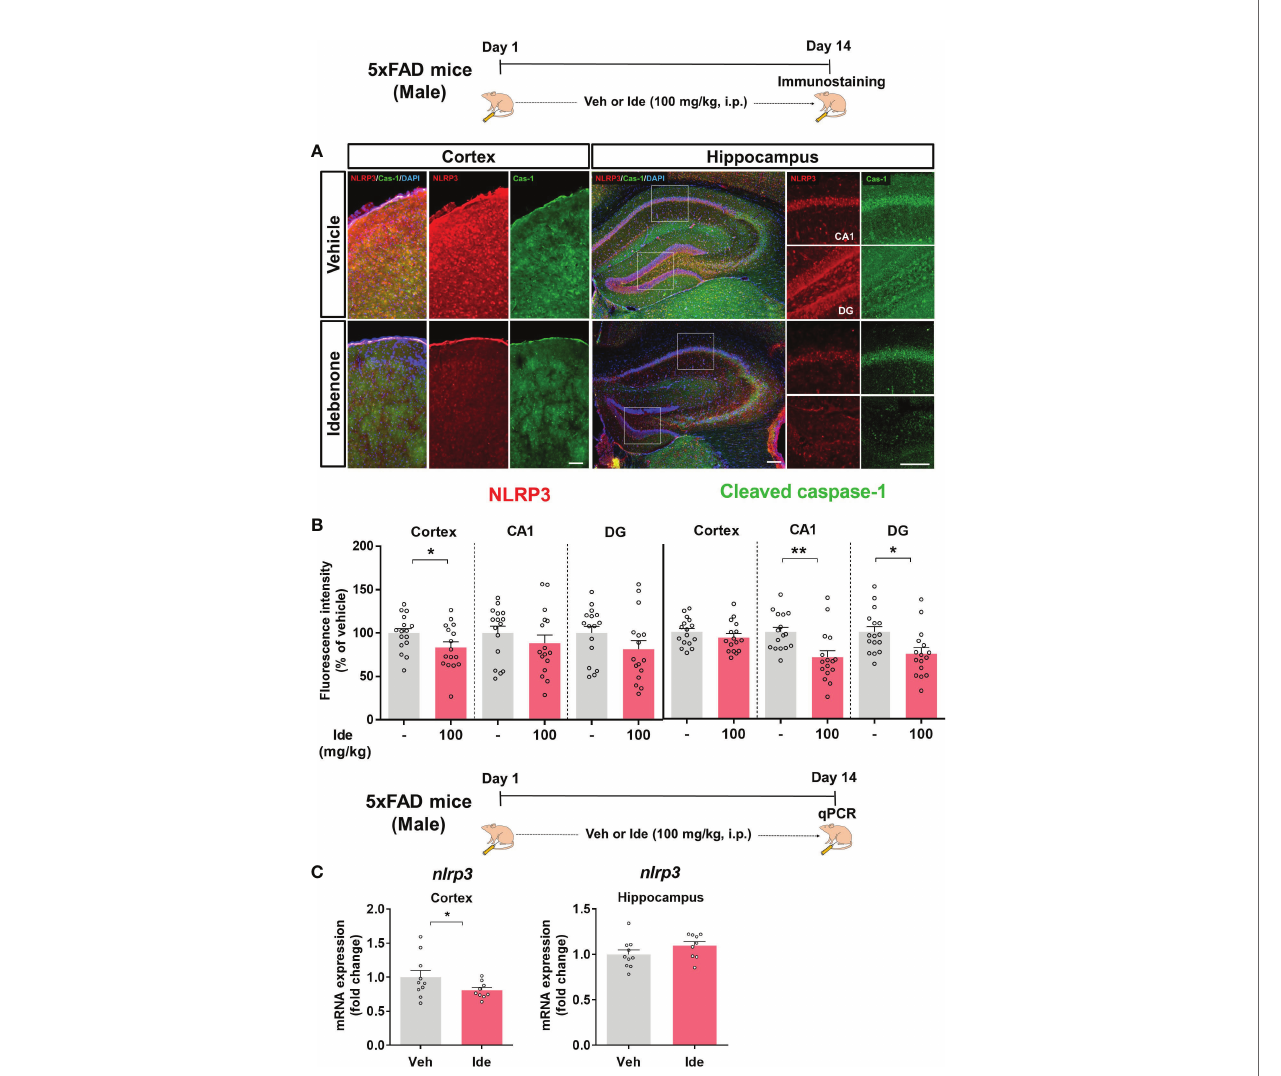
FIGURE 11 | Idebenone inhibits A b -mediated NLRP3/caspase-1 axis activation in 5xFAD mice. (A) Representative images of NLRP3 and cleaved caspase-1 immuno fl uorescence in the cortex and hippocampus. (B) Quanti fi cation of the fl uorescence intensity of NLRP3 and cleaved caspase-1 (n = 16 brain slices from 4 mice/group). (C) Real-time PCR detection of relative mRNA levels of nlrp3 in the cortex and hippocampus in 5xFAD mice (n = 9-10 mice/group). *p < 0.05 and **p < 0.01. Scale bar = 200 m